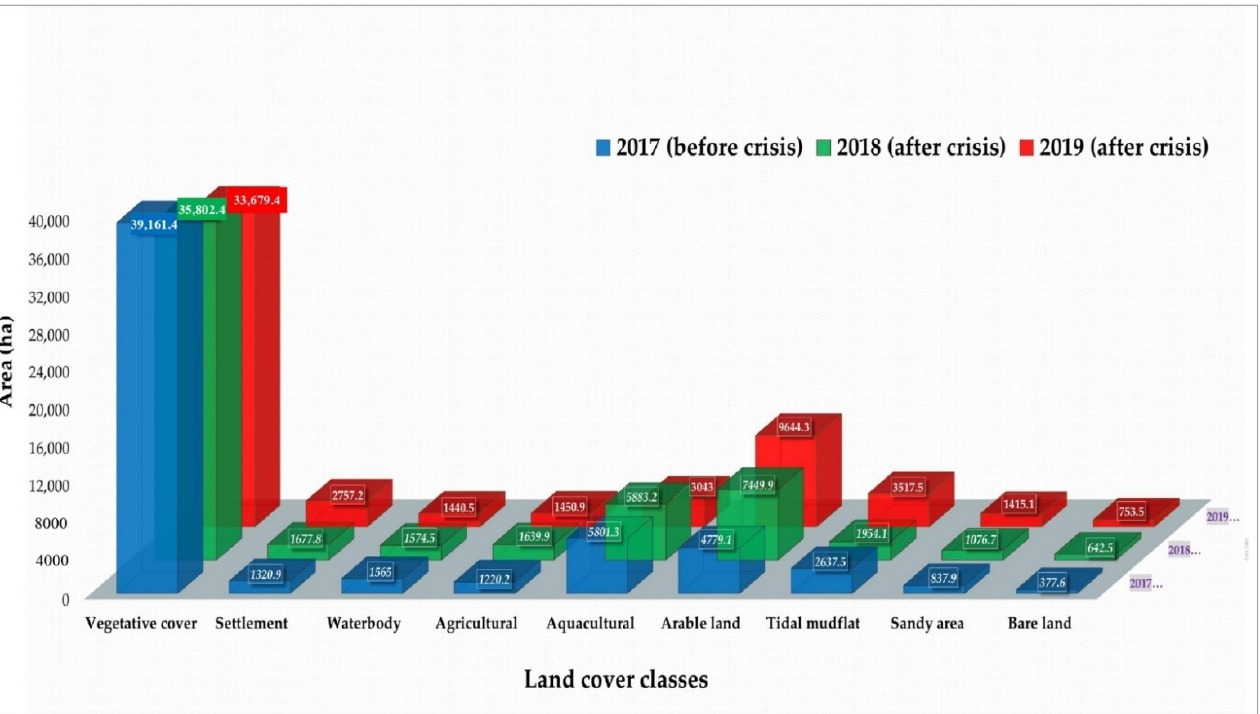
Figure 6. Land cover area (in thousands of hectares) changes in Ukhiya-Teknaf region before and after the Rohingya refugee crisis between 2017–2019, by the period of observation. Table 4. Gain and loss of different LULC areas (in hectares and percentage) in Ukhiya-Teknaf, pre and post refugee crisis, by the period of